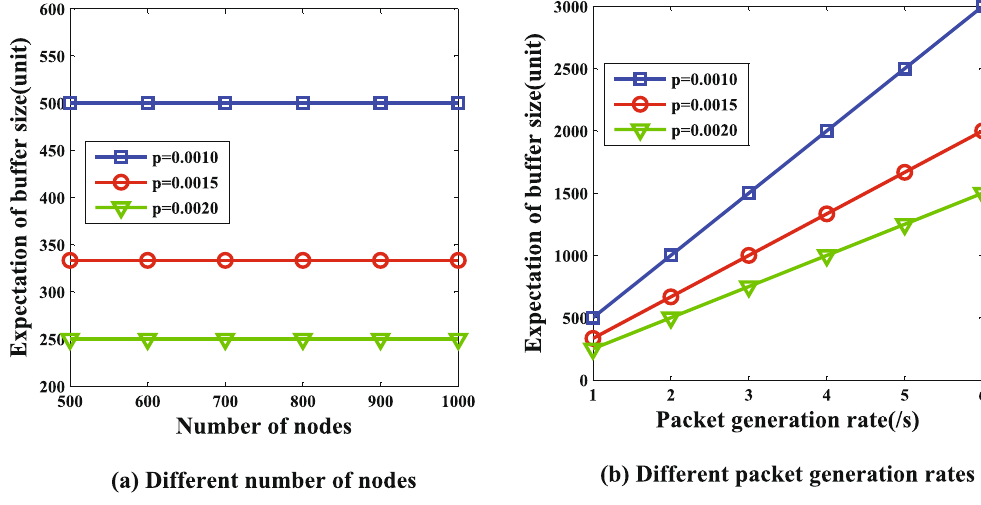
Figure 7. Buffer size in subcritical